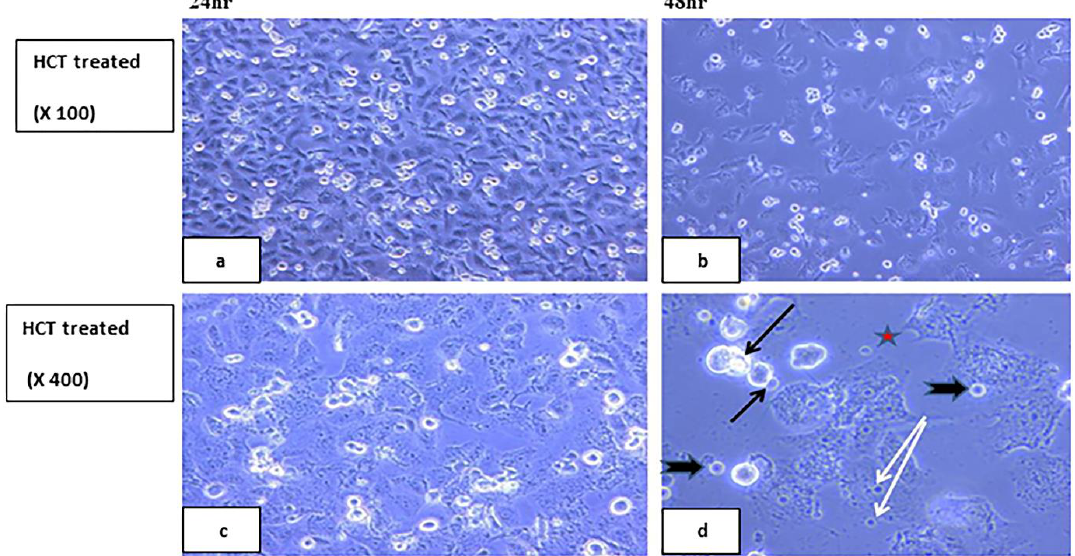
Figure 12. Control (untreated) human HCT cell lines. Panels ( a , b ) show spindle shaped attached cells. Panel ( b ) shows 90% confluent spindle shaped cells 48 h post culture. Phase contrast, X100. Panels ( c , d ) show spindle shaped attached cells with vesicular nuclei and granular cytoplasm and also some polygonal cells with multiple processes. Panel ( d ) shows, in addition, rounded floating cells (white arrows) and dividing cells 48 h post culture (black arrow). Phase contrast, X400.